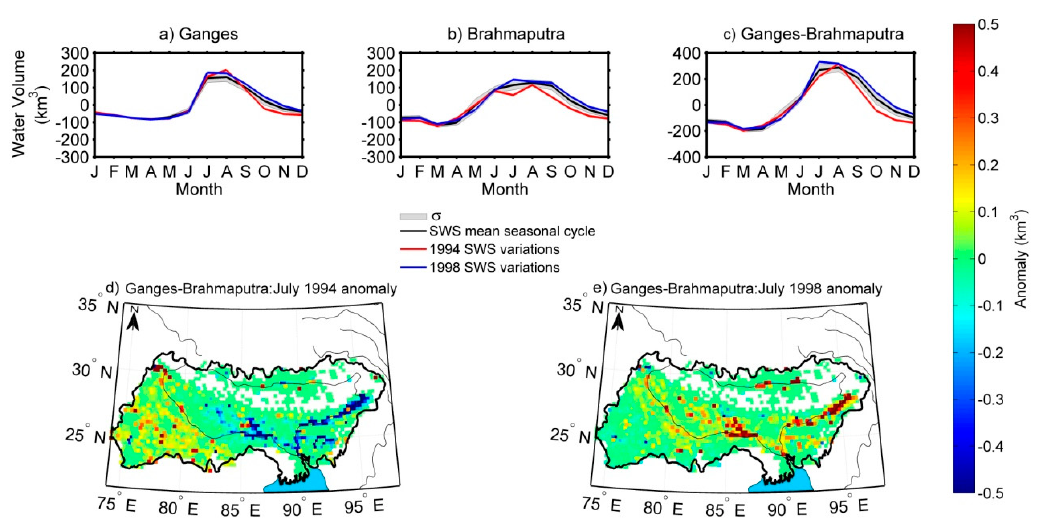
Figure 10. Spatio-temporal variations of SWS estimated by the GIEMS/ASTER technique for the two years of 1994 and 1998: ( a – c ) show the SWS mean seasonal cycle (black) and its standard deviation (shaded gray) for the 1993–2007 period along with SWS variations for 1994 (red) and 1998 (blue) over the Ganges, the Brahmaputra, and the Ganges-Brahmaputra respectively; ( d , e ) show the spatial distribution of SWS anomalies over the GB system for July 1994 and July 1998 respectively.